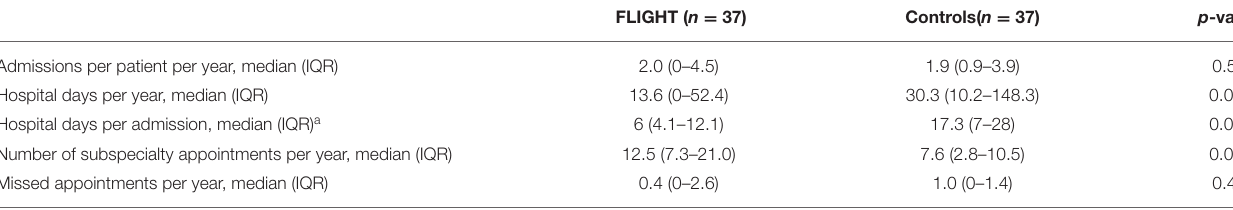
TABLE 2 | Healthcare utilization comparing FLIGHT cases and matched controls.